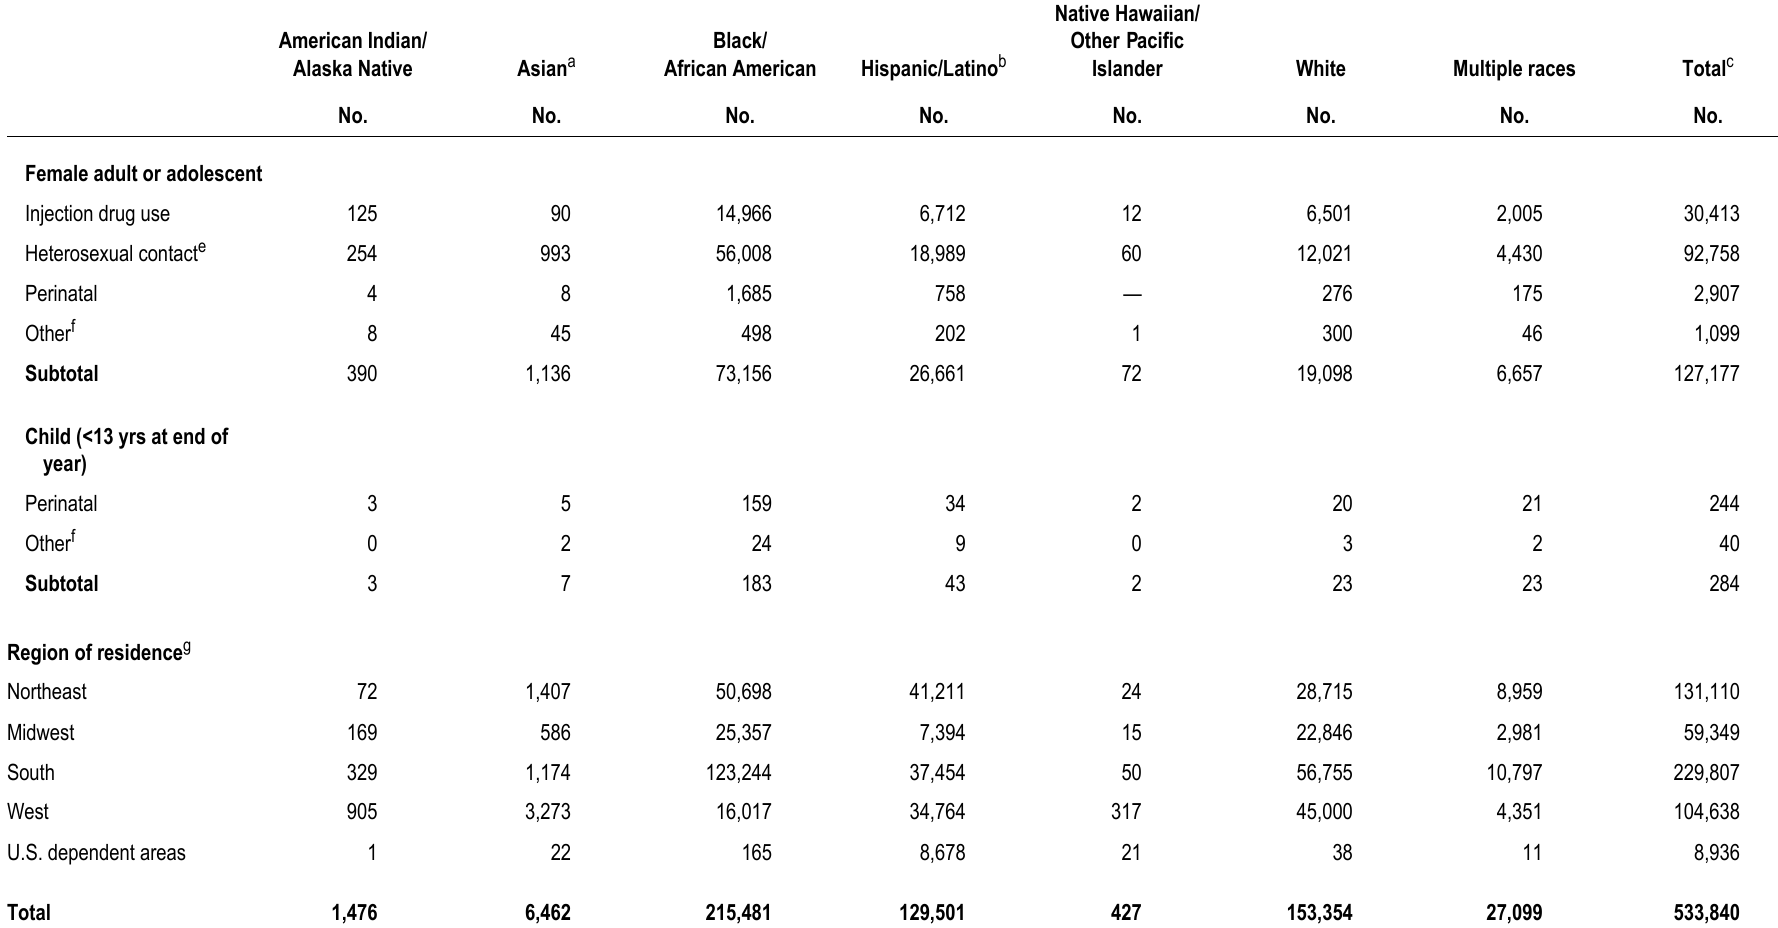
Table 25b. Persons living with diagnosed HIV infection ever classified as stage 3 (AIDS), by race/ethnicity and selected characteristics, year-end 2017—United States and 6 dependent areas